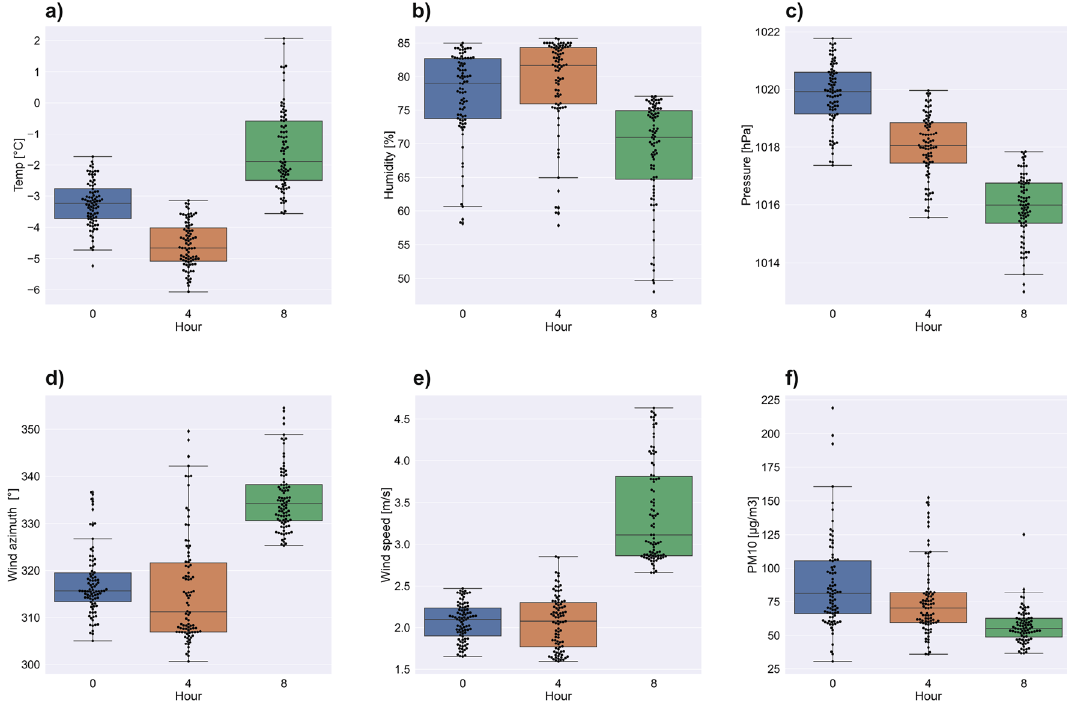
Figure 4. Box and swarm plots for temperature ( a ), humidity ( b ), pressure ( c ), wind azimuth ( d ), wind speed ( e ), and PM10 concentration ( f ) on the 11th of March.